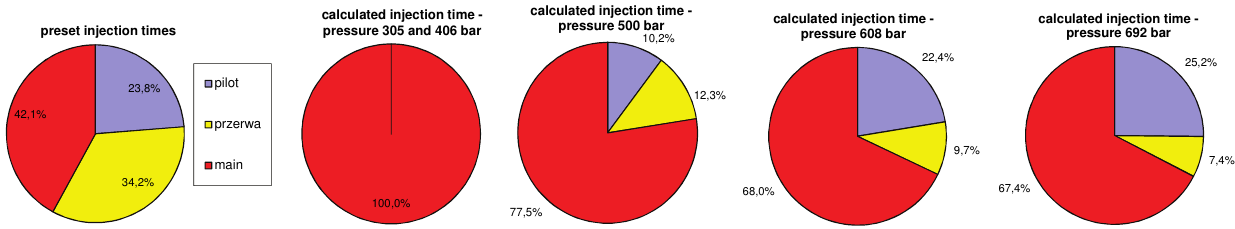
Fig. 10. Percentage shares of calculated times of individual portions and gaps in total, complete injection time for the first group of the